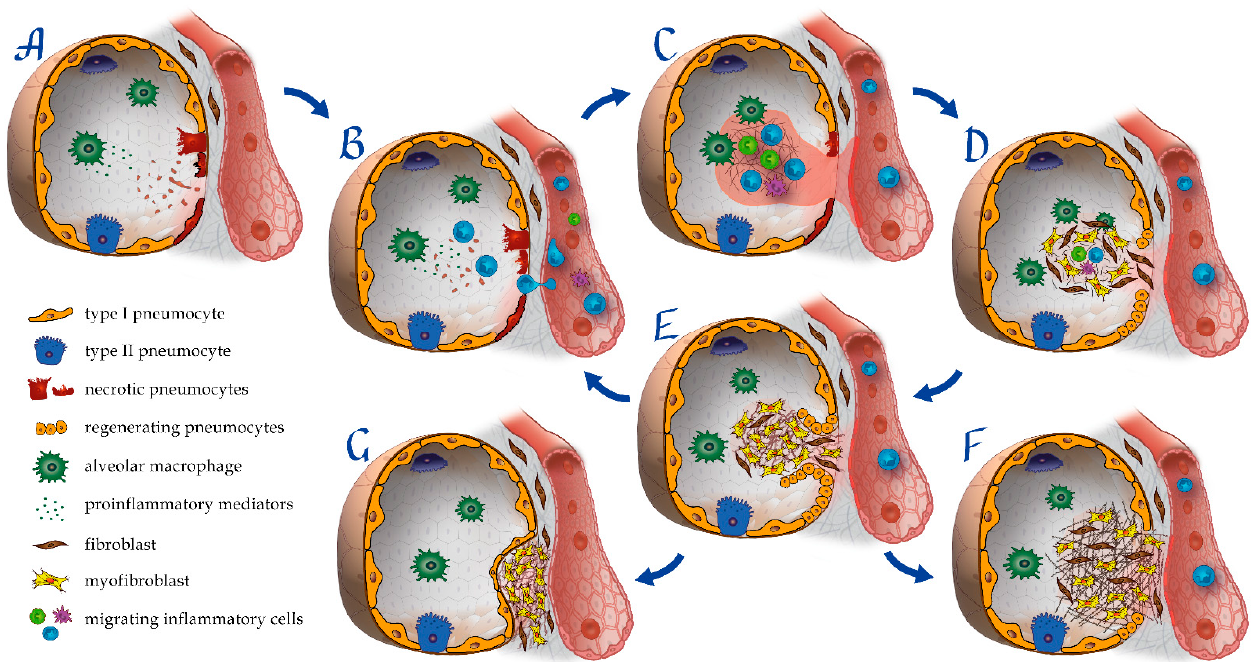
Figure 3. Pathogenesis of secondary PIOP and OP-like PCPS. ( A ) Virus-induced alveolar injury with alteration and necrosis of alveolar epithelial cells. ( B ) Aberrant inflammatory-induced chemotaxis of macrophages and neutrophils to the lung tissue. ( C ) Inflammatory-induced ROS production and epithelial and endothelial damage, vascular leakage with alveolar hemorrhage, and intra-alveolar edema. ( D ) Alveolar spaces colonization by pulmonary fibroblasts and myofibroblasts. Extracellular myxoid matrix deposition in the intra-alveolar space. ( E ) Progressive organization of intra-alveolar granulation tissue into mature fibrotic collagen-rich bundles. ( F ) Recurring cycles of alveolar epithelial cells damage and subsequent regeneration lead to gradually interlobular and intralobular septal thickening associated with bronchial dilations, suggesting the development of fibrosis. ( G ) The intra-alveolar buds are remodeled into the interstitium, and the collagen bundles (fibroblastic plugs) are covered with type I alveolar epithelial cells.